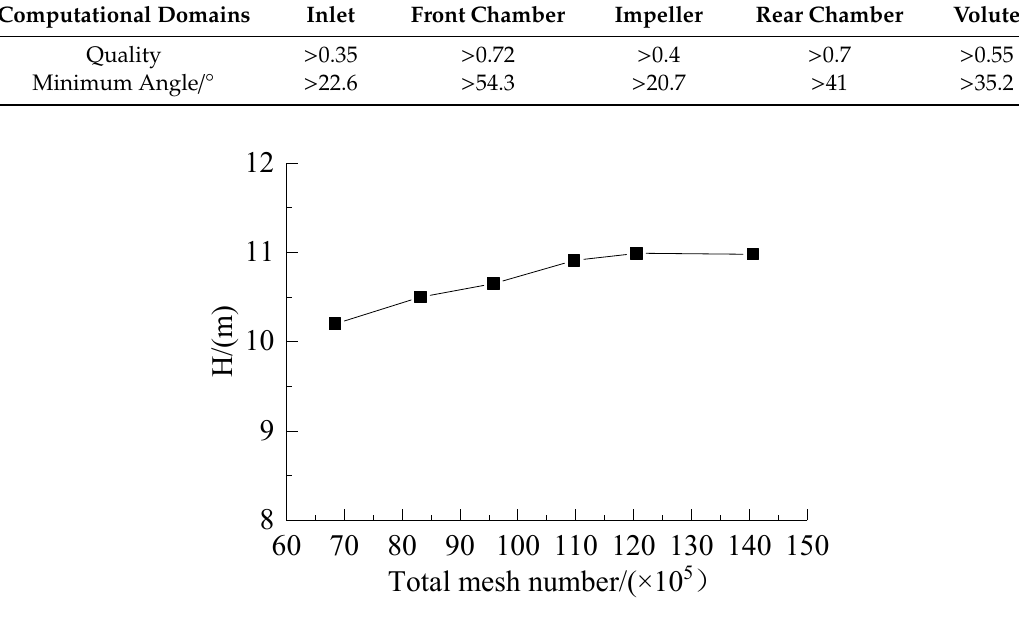
Figure 5. Pump head with different mesh number. Table 5. Performance results with different turbulence models under design flow rate condition.